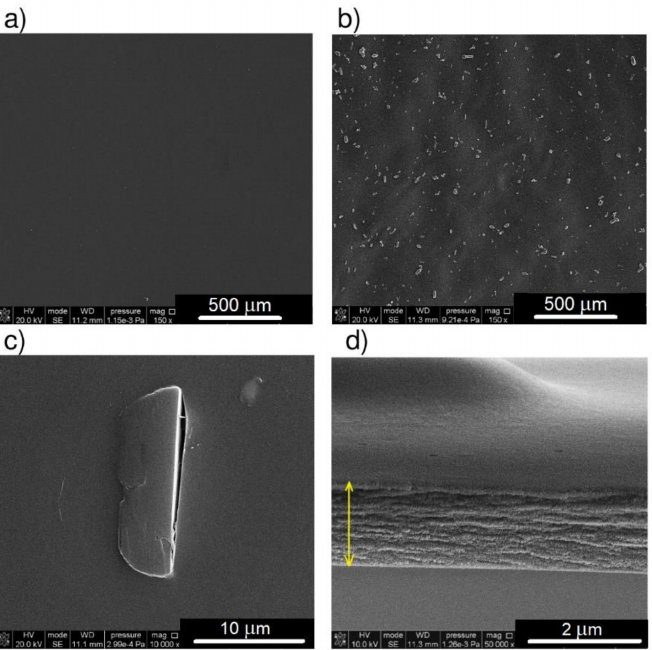
Figure 3. SEM images of chitosan ( a ) and chitosan with 5% DMASQ at 150 × magnification ( b ); single DMASQ crystal embedded in CS film, magnification 10,000 × ( c ) and cross-section of CS + 2% DMASQ film, magnification 50,000 × , the arrow shows the thickness of the film ( d